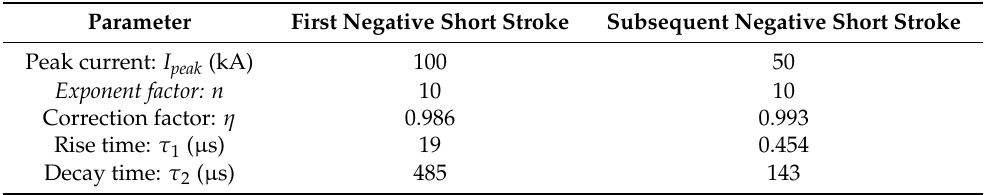
Table 1. Parameters for lightning current waveforms, first short stroke and subsequent short stroke.